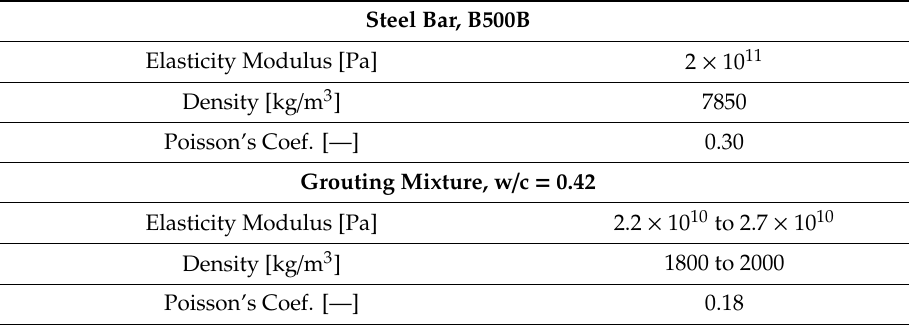
Table 2. Material properties of steel bar and grout mixtures.